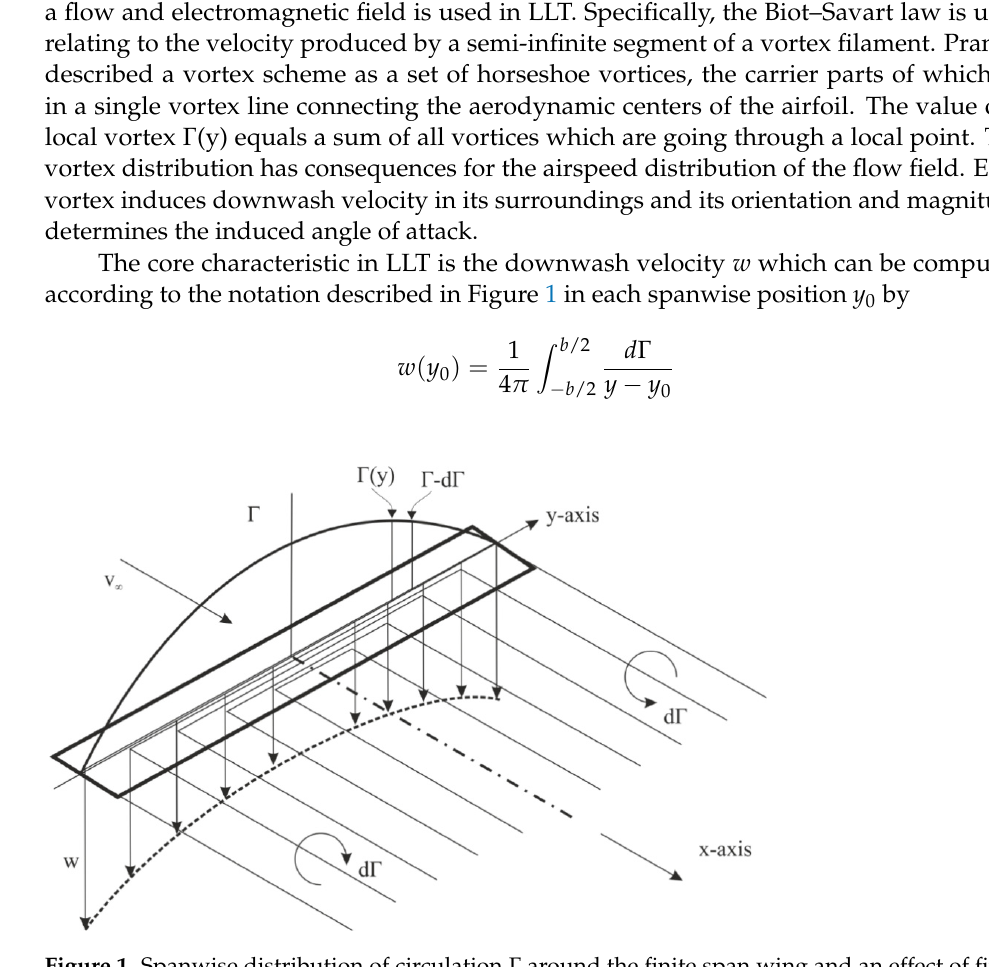
Figure 1. Spanwise distribution of circulation Γ around the finite span wing and an effect of finite span on downwash velocity w.